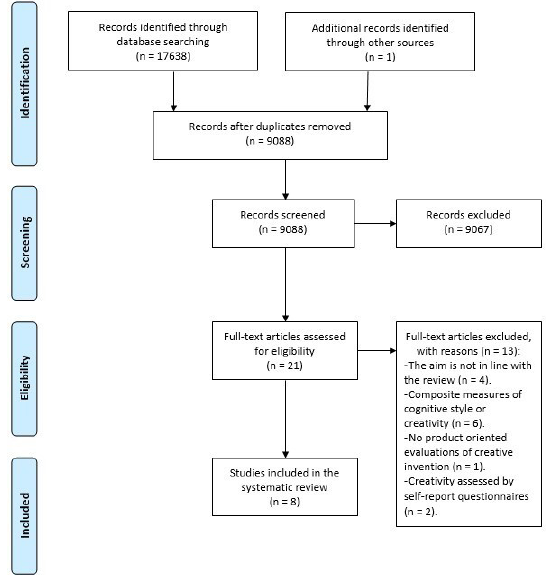
Figure 1. Flow diagram of the extracted studies (source: created by